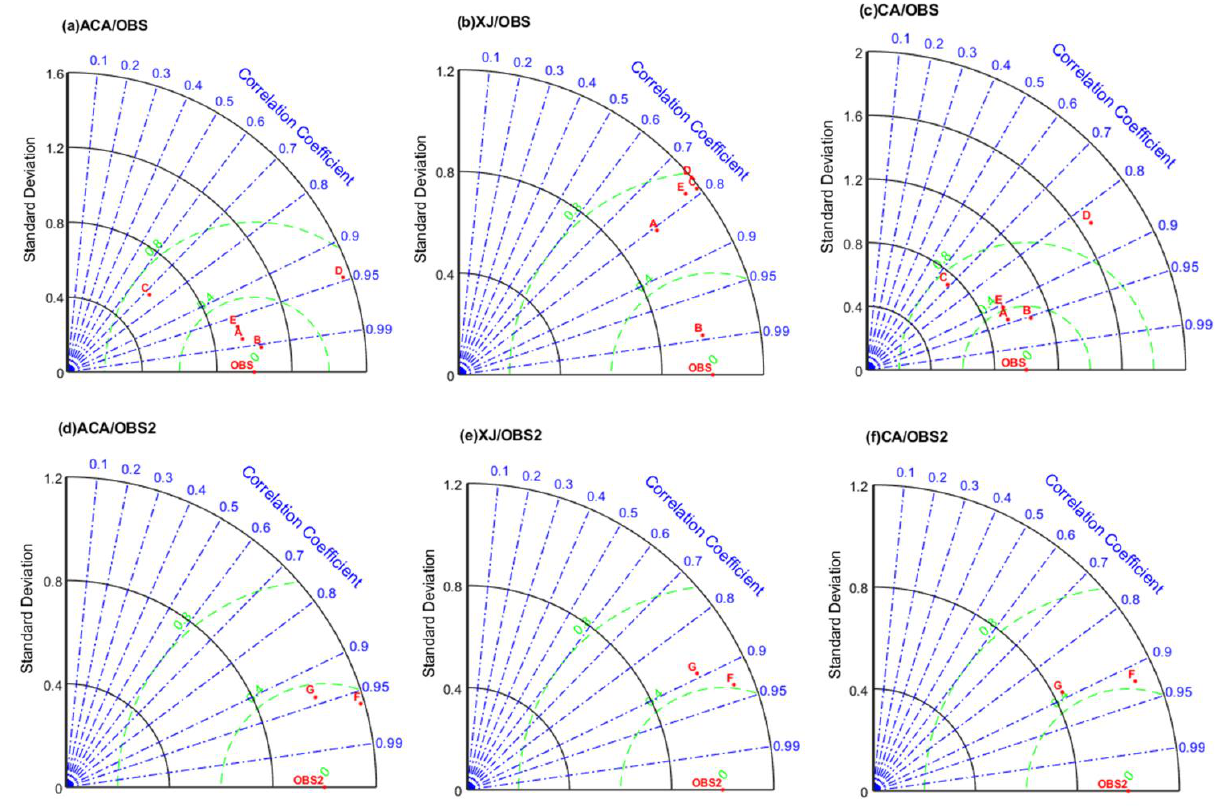
Figure 10. Taylor diagram of Rx1month between the seven products and observations (OBS and OBS2) in ACA ( a , d ), XJ ( b , e ), and CA ( c , f ). The capital letters in the diagram represent the seven precipitation products, A (CRU), B (GPCC), C (MERRA-2), D (ERA5-Land), E (PREC/L), F (GPM IMERG), and G (PERSIANN-CDR).